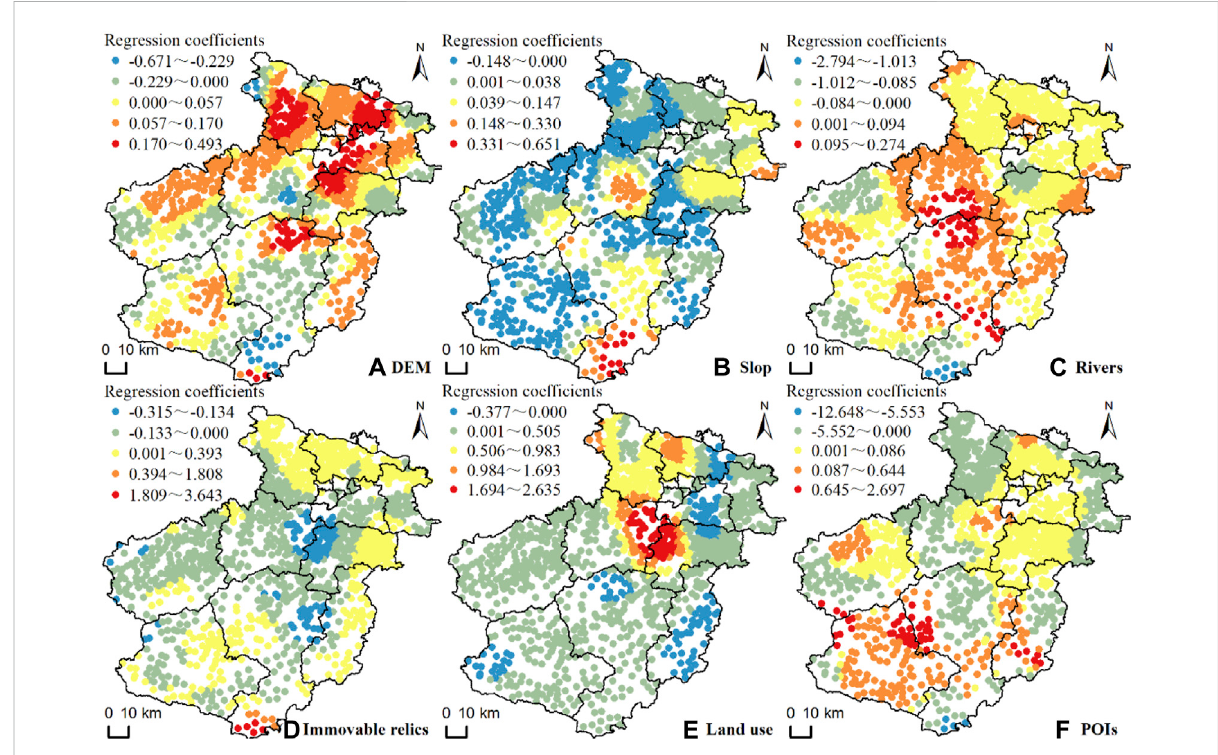
FIGURE 5 Spatial distribution of regression coef fi cients of driving factors in the GWR model: (A) DEM; (B) Slope; (C) Rivers; (D) Immovable relic; (E) Land use; (F)